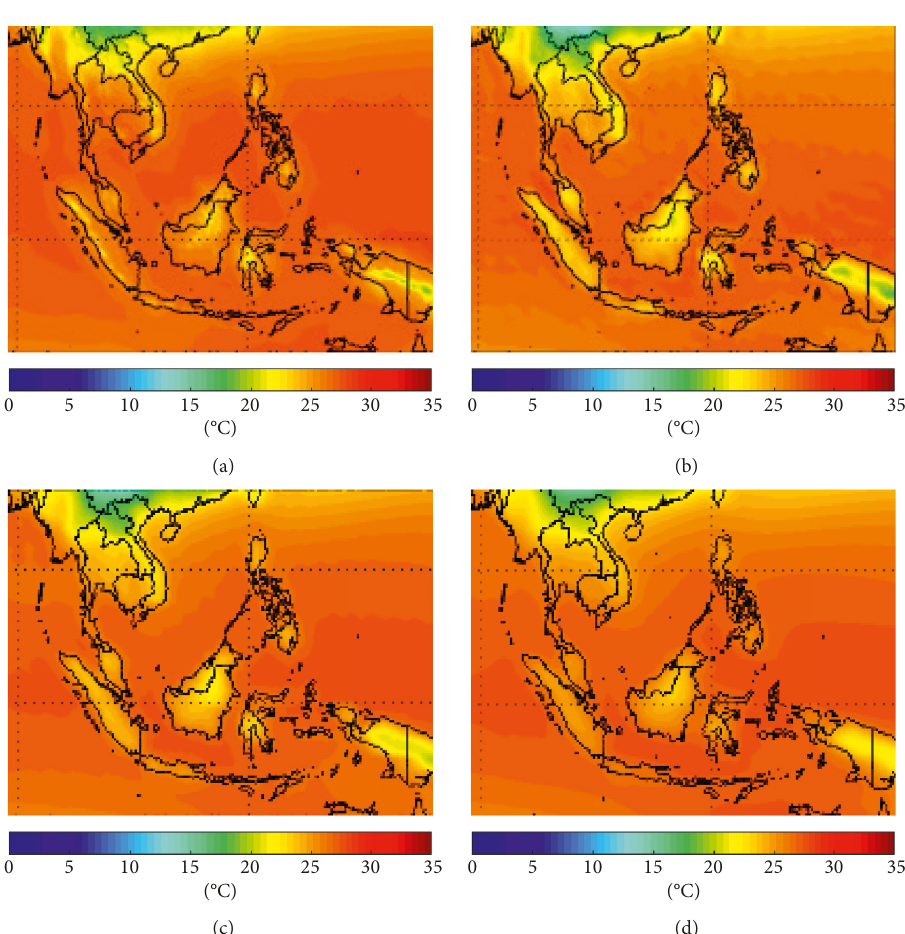
Figure 6: Comparisons of the mean annual temperatures (Mean-Ts) ( ° C) for years 1960–1999 of (a) observations, (b) CNRM-CM5-2, (c) 6- GCM-Ensemble, and (d)